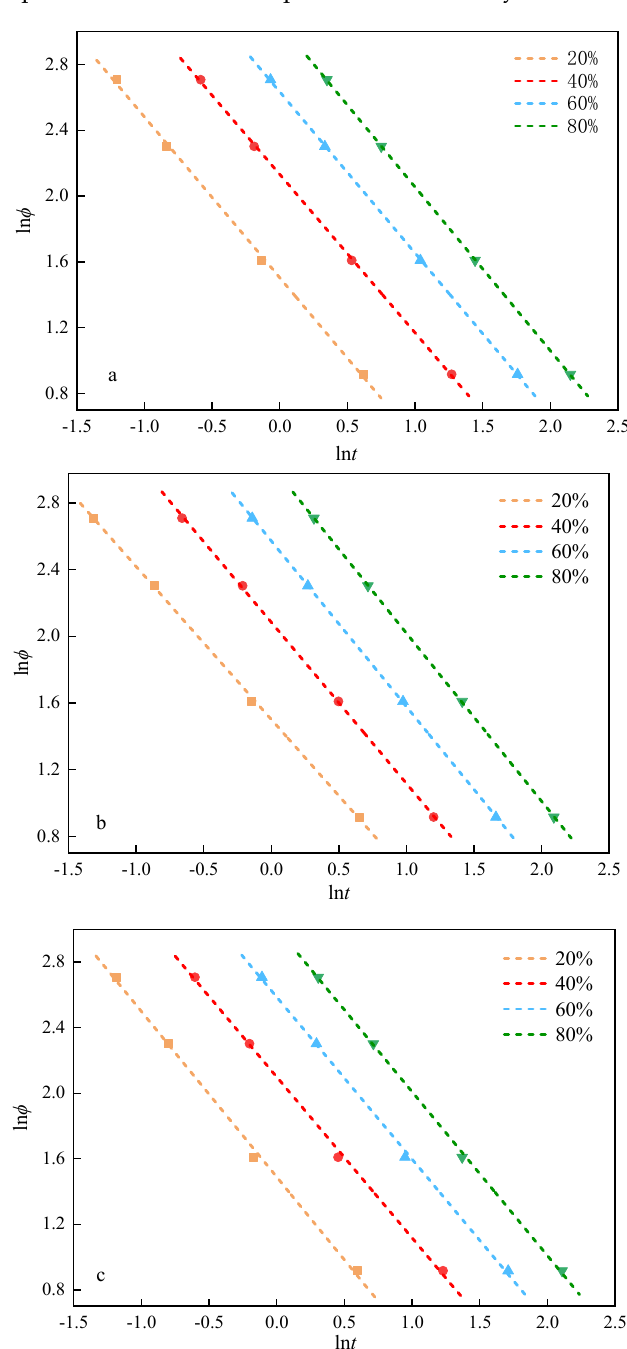
Figure 8. Relationship between the relative crystallinity and temperature at different cooling rate: ( a ) VGO4, ( b ) VGO4 + 100 ppm AMAC, and ( c ) VGO4 + 100 ppm EMAC. According to Formula (1), the plots of ln ϕ as a function of ln t are shown in Figure 9. The plots of the three samples are almost parallel straight lines, indicating that these two parameters had a good linear relationship. This work confirms that the equation proposed by Mo is suitable for studying the non-isothermal crystallization process of paraffin in VGO4. The intercept F ( t ) and the slope α were obtained from Figure 9, where F(t) can reflect the rate of the crystallization, and the larger the F ( t ) is, the smaller the crystalliza- tion rate. The parameters reported in Table 11 showed that, when the cooling rate was the same, the crystallization rate of paraffin in VGO4 with comb-type copolymers was higher than that in VGO4, indicating that the AMAC and EMAC comb-type copolymers pro- moted the crystallization process and increased the crystallization rate of paraffin, which led to the crystals more aggregated and the crystallite size big, and therefore, relatively complete morphologies of the crystals were observed. These modifications increased the filtration speed and enhanced the production efficiency of the MEK–toluene unit.